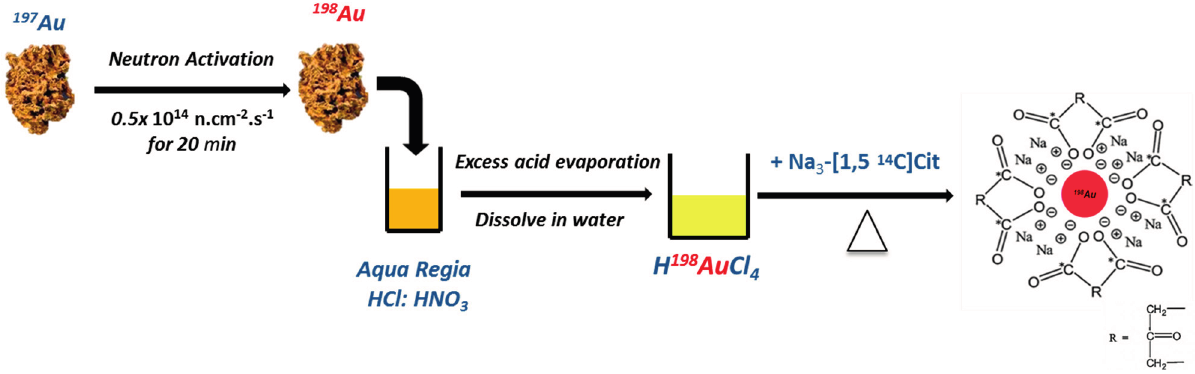
Figure 5. Schematic showing the synthesis of dual-radiolabeled AuNPs starting with the stable 197 Au isotope of gold. The neutron activation step is unique to the radioactive